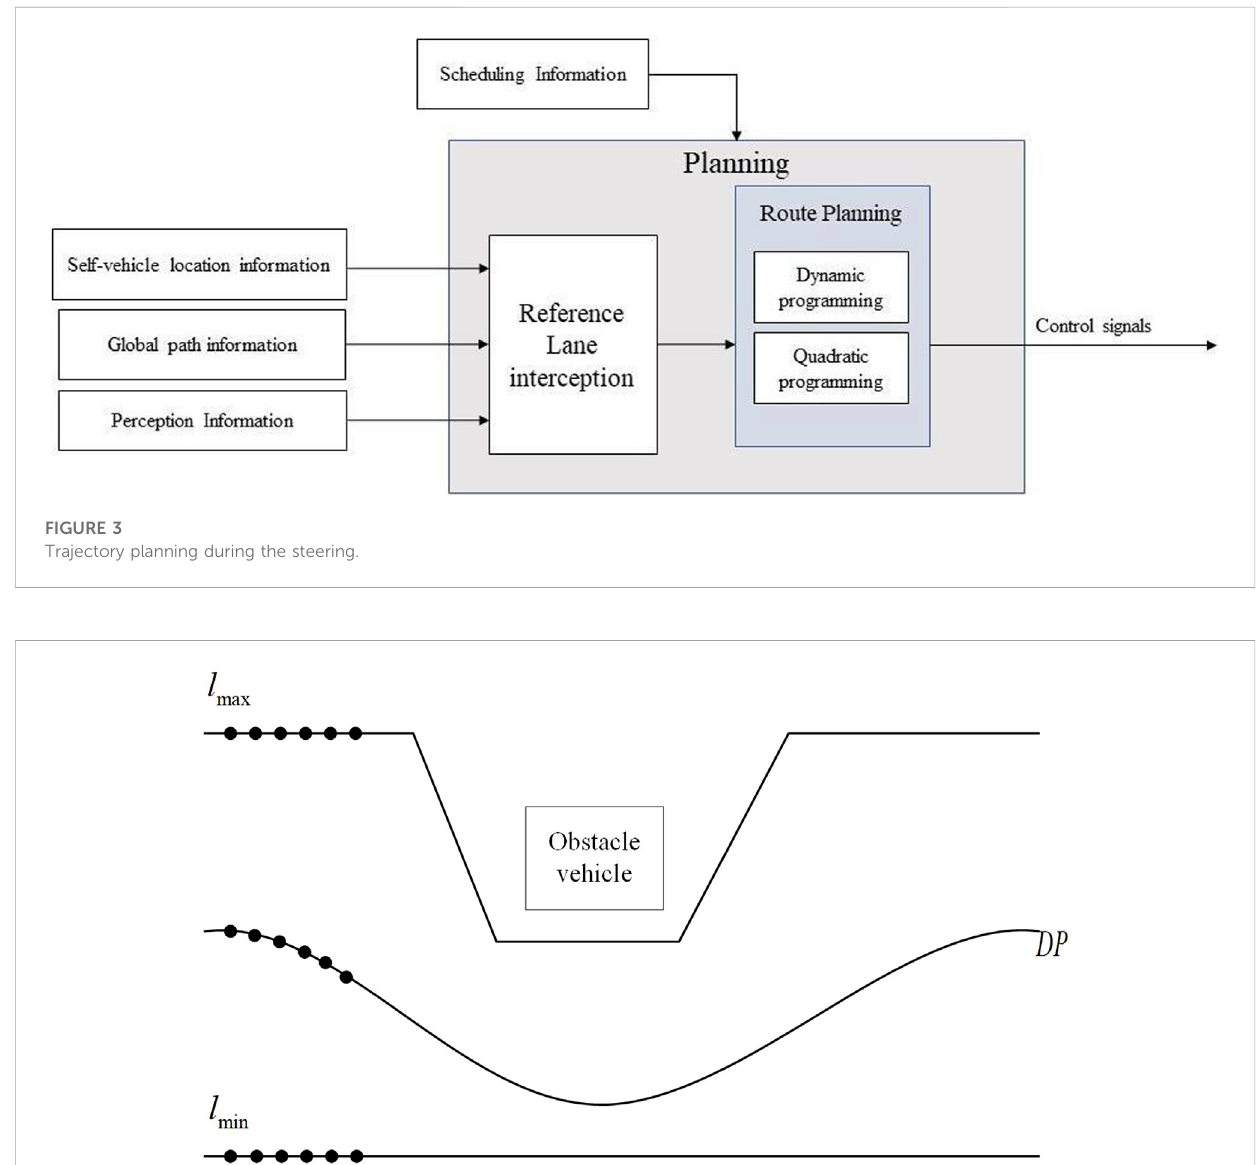
FIGURE 4 Path planning feasible space(DP).